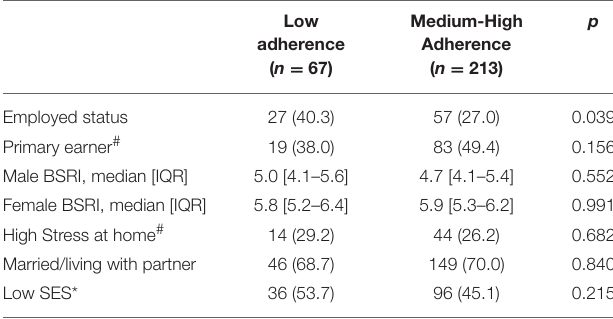
TABLE 2 | Gender-related factors of EVA patients according to pre-admission medication